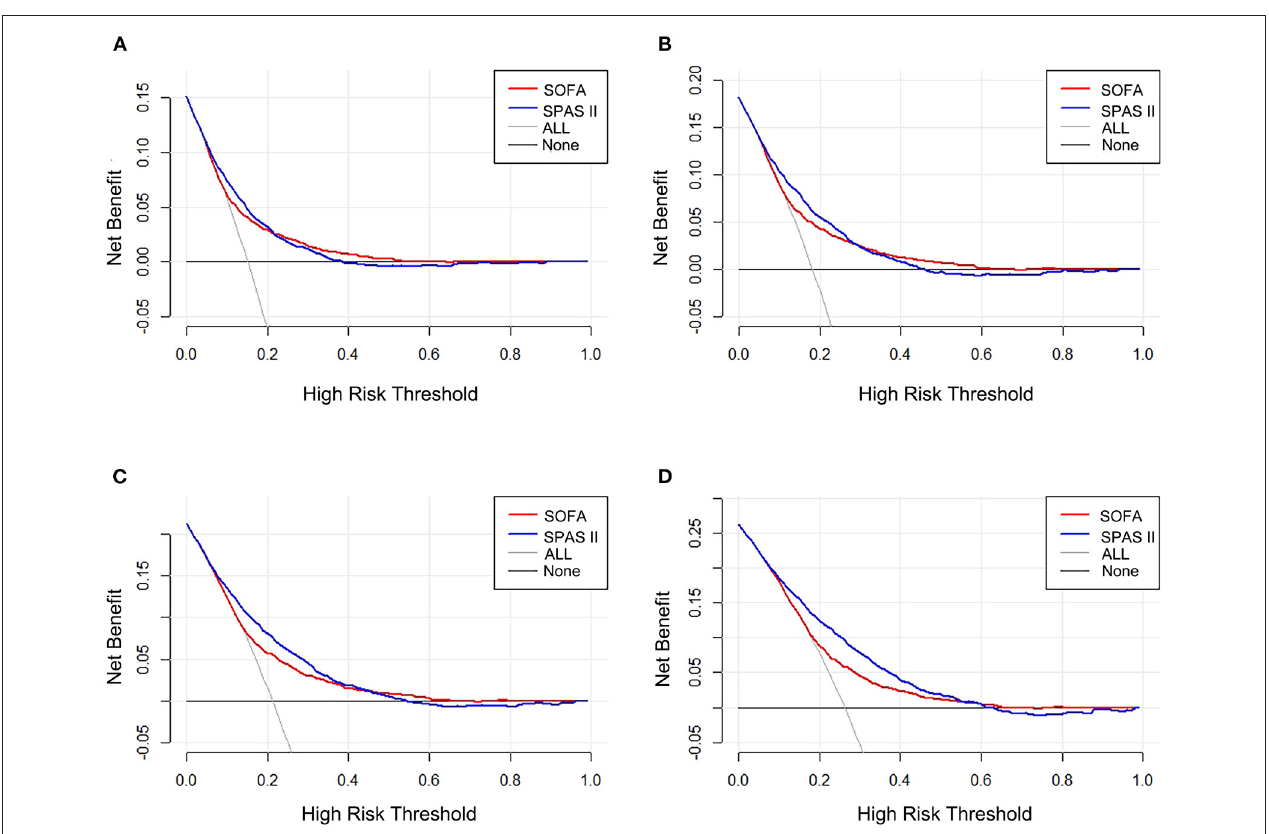
FIGURE 4 | Decision curve analysis (DCA) of the two scoring systems. (A) In-hospital mortality, (B) 28-day mortality, (C) 90-day mortality, and (D) 1-year